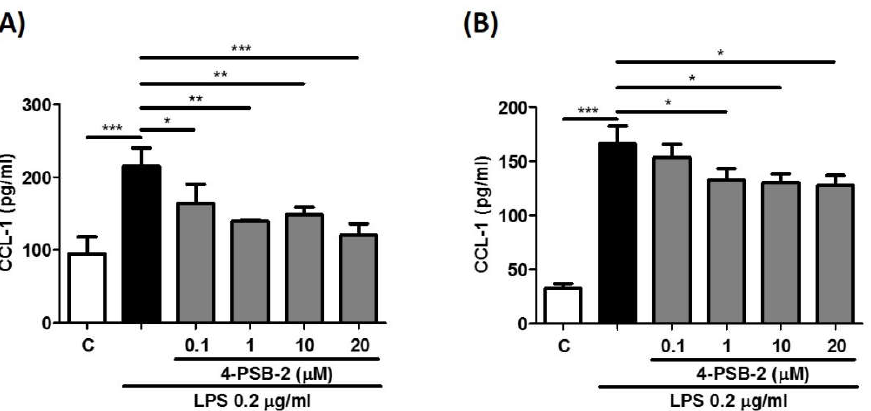
Figure 1. 4 − PSB − 2 was able to suppress the LPS − induced CCL − 1 production in THP − 1 cells. After pretreatment with medium alone (C, white bar) or 4-PSB-2 (0.1, 1, 10, and 20 µM) for 2 h followed by LPS stimulation, the CCL-1 concentration was determined for 24 h ( A ) and 48 h ( B ). Data present the means ± SD of 3 independent experiments. (* p < 0.05, ** p < 0.01, and *** p < 0.001).